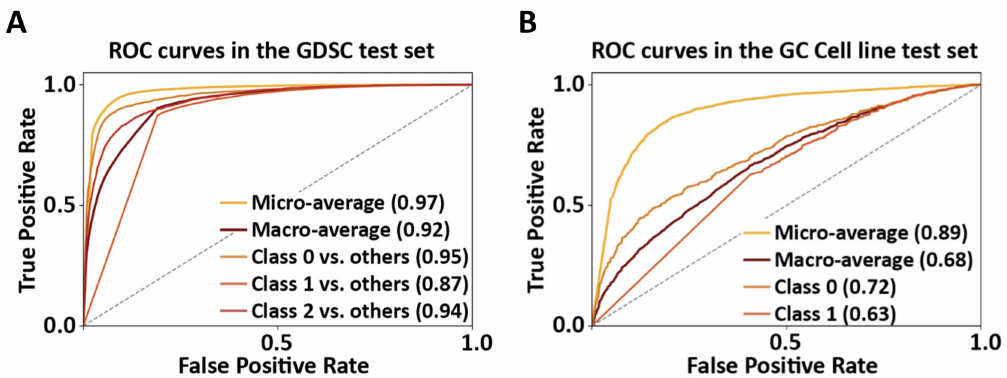
Figure 3. GoogLeNet model performance on GDSC test set and GC cell line test set. Micro-/macro-average and each class’ OVR AUROCs are depicted. The graphs represent the performance of GoogLeNet in the GDSC test set ( A ), and in the GC cell line test set ( B ). It is noted that the GC cell line test set, from CCLE, did not contain class 2 cases. The numerals in parentheses indicate the AUROCs.